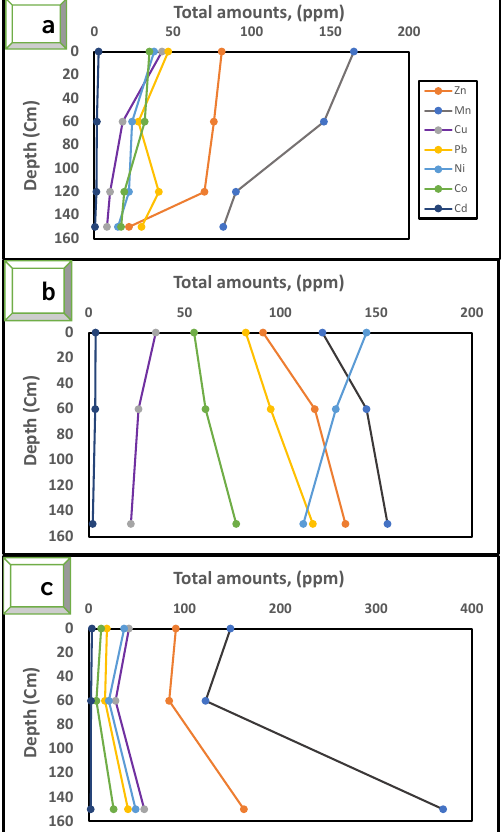
Figure 2. Distributions of total heavy metals in the different geomorphological units tested: ( a ) AT1, AT2, AT3, LT1, and LT3; ( b ) LB2 and LB1; ( c ) AB2 and AB1. ( a – c ) are symbols. 3.3. Soil Degradation The data in Table 4 indicated that the soils of the terraces, AT1, AT2, LT1, and LT3, had a low degree of salinization (EC reached to 0.89 dS/m), as they were characterized by